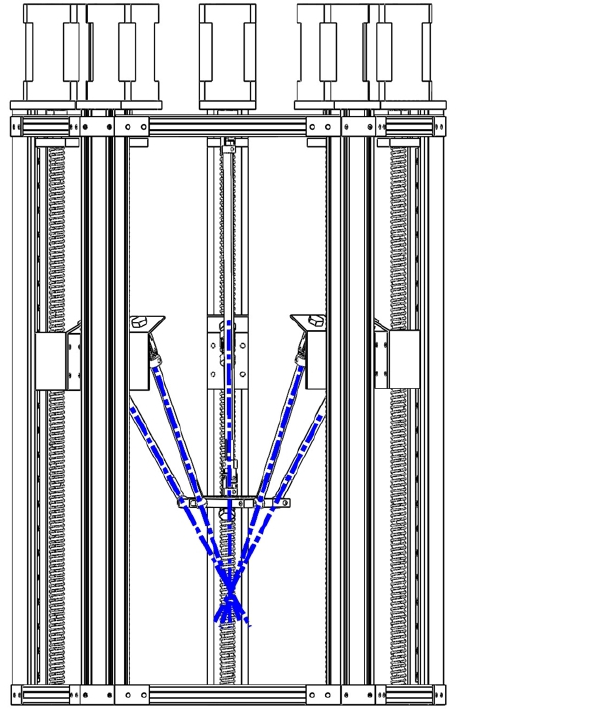
Figure 4. Singular position of preliminary scheme.